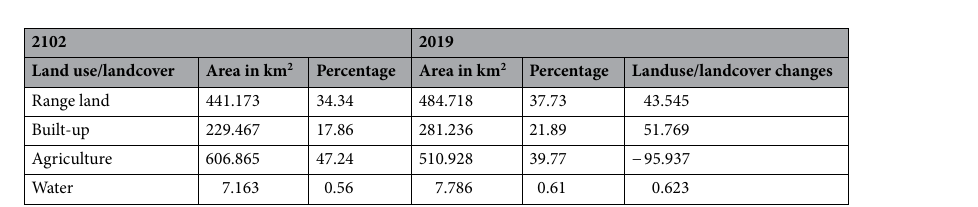
Figure 10. Landuse/landcover of the study area. ( a ) The 2012 land use/land cover. ( b ) The 2019 landuse/ landcover.